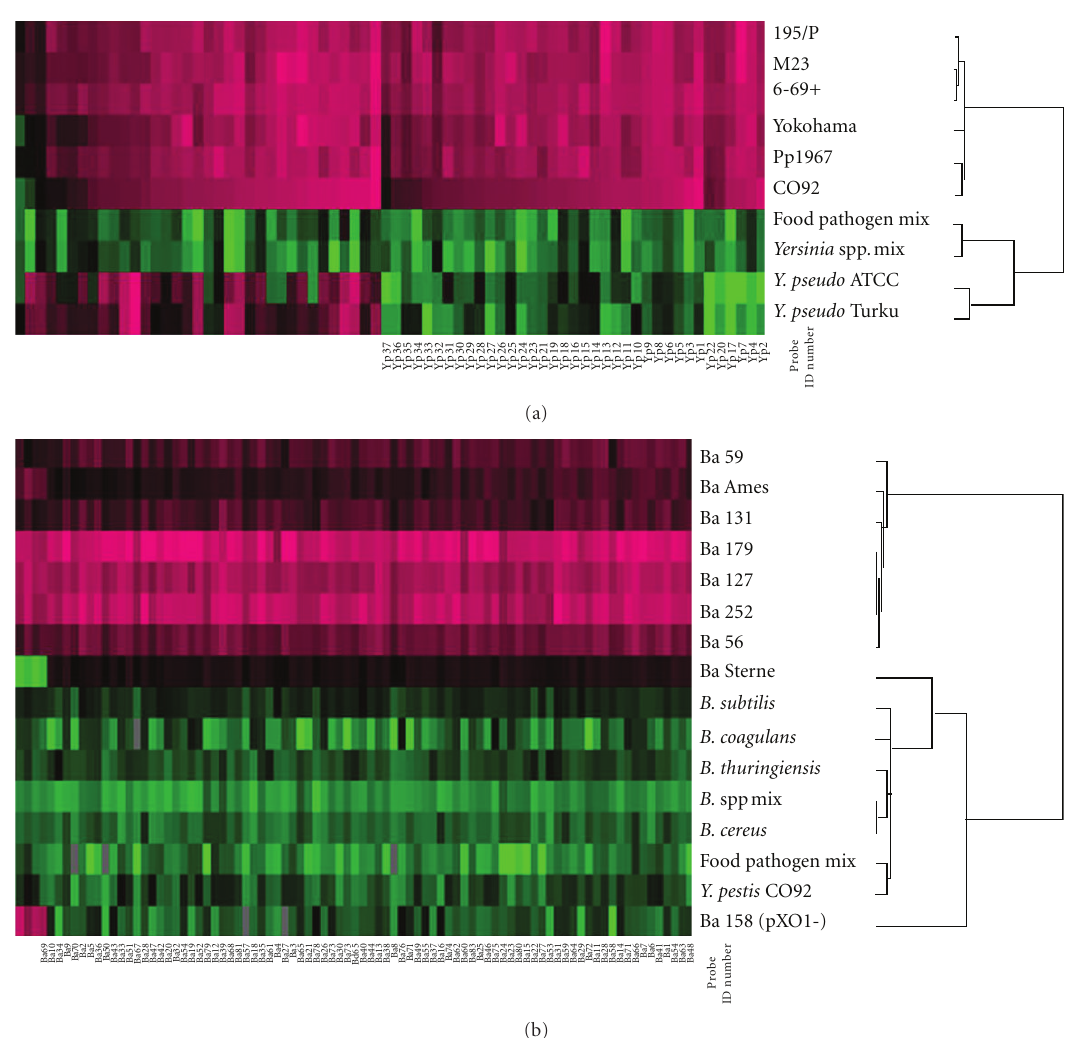
Figure 2: Unique patterns of the heat map and clustering images generated from the data of Y. pestis (a) and B. anthracis (b) specific probes. The total intensity of the positive spots for either Y. pestis or B. anthracis was normalized using microarray data analysis software (Cluster and Treeview [5]) after converting to log 2 scale. Probes with significant intensity are shown in pink. The 37 probes for Y. pestis and 83 for B. anthracis have probe ID numbers underneath the heat